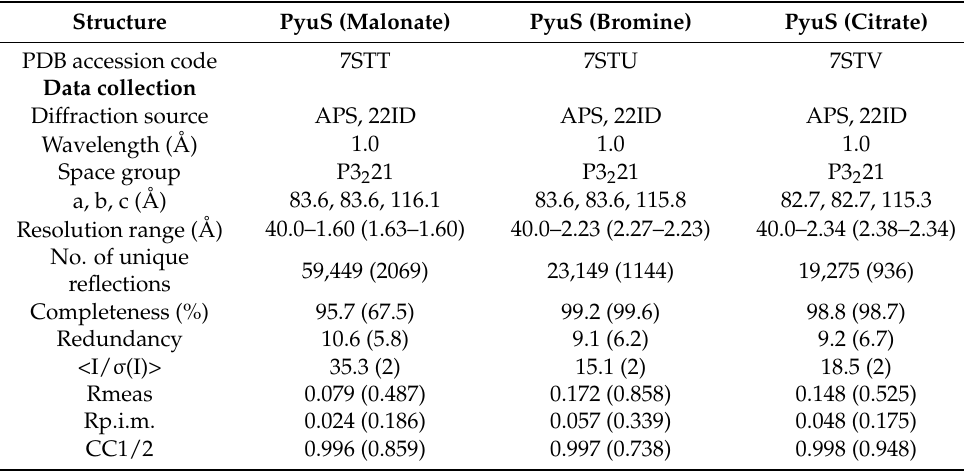
Table 2. Data collection and refinement statistics for PyuS crystal structures. Values in parentheses are for the highest resolution shell. RMSD—root mean square